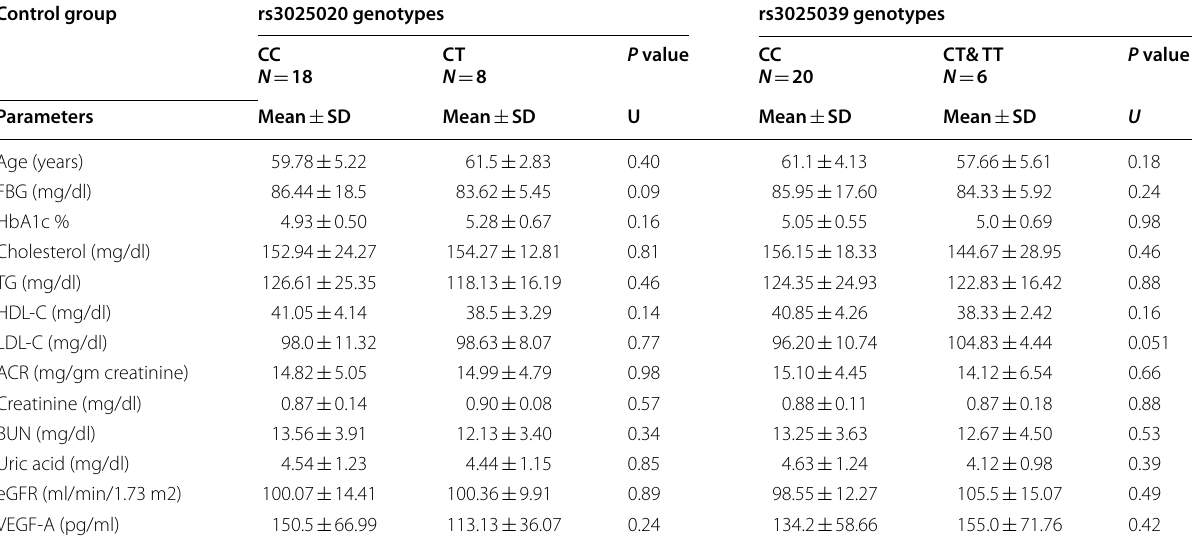
Table 5 Relationship between VEGF-A rs3025020 and rs3025039 genotypes and different studied parameters in control group